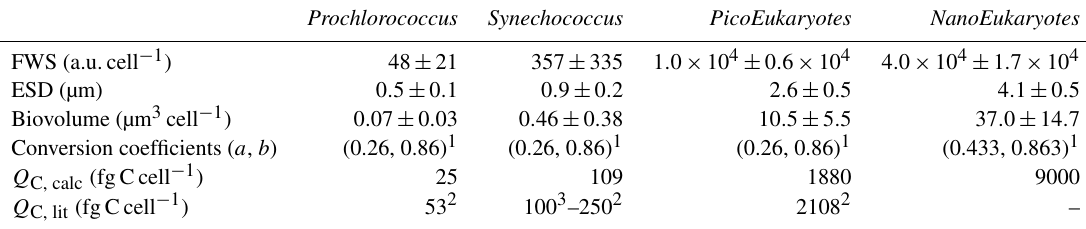
Table 2. Mean and SD of forward scatter (FWS), equivalent spherical diameter (ESD) and biovolume of Prochlorococcus , Synechococcus , PicoEukaryotes (PicoE) and NanoEukaryotes (NanoE) during the OSCAHR campaign. ESD was computed according to the power law relationship (log ( Size ) = 0 . 309 · log ( FWS ) − 1 . 853, n = 17, r 2 = 0 . 94) obtained with silica beads of known diameter. Biovolumes were calculated considering that the cells were spherical. Biovolumes were converted into a mean carbon cellular quota ( Q C, calc ) according to the Q C, calc = a · Biovolume b relationship using conversion factors a and b reported by (1) Menden-Deuer and Lessard (2000). Carbon cellular quotas ( Q C, lit , lit for literature) from (2) Campbell et al. (1994) and (3) Shalapyonok et al. (2001) were reported for comparison. Prochlorococcus Synechococcus PicoEukaryotes